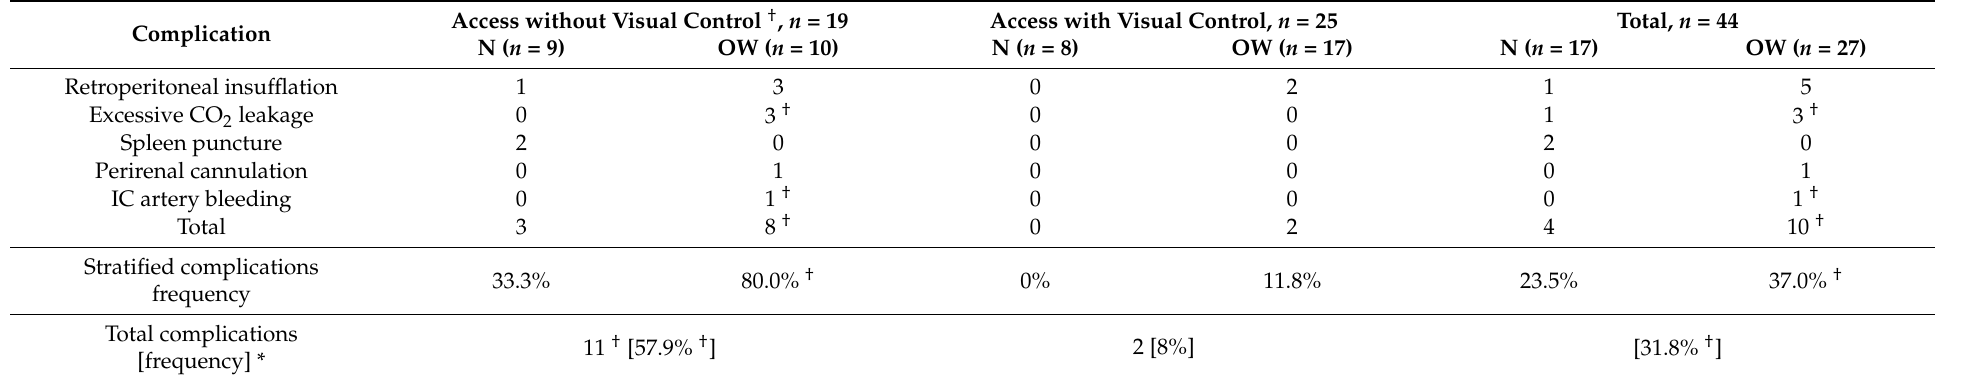
Table 4. Complications related to the visual control during access